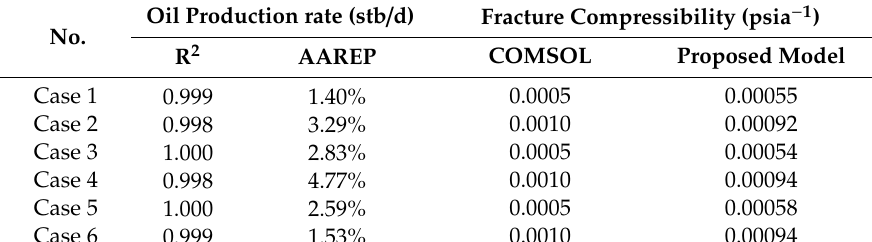
Table 2. Comparison between prescribed fracture conductivity and model-predicted value.